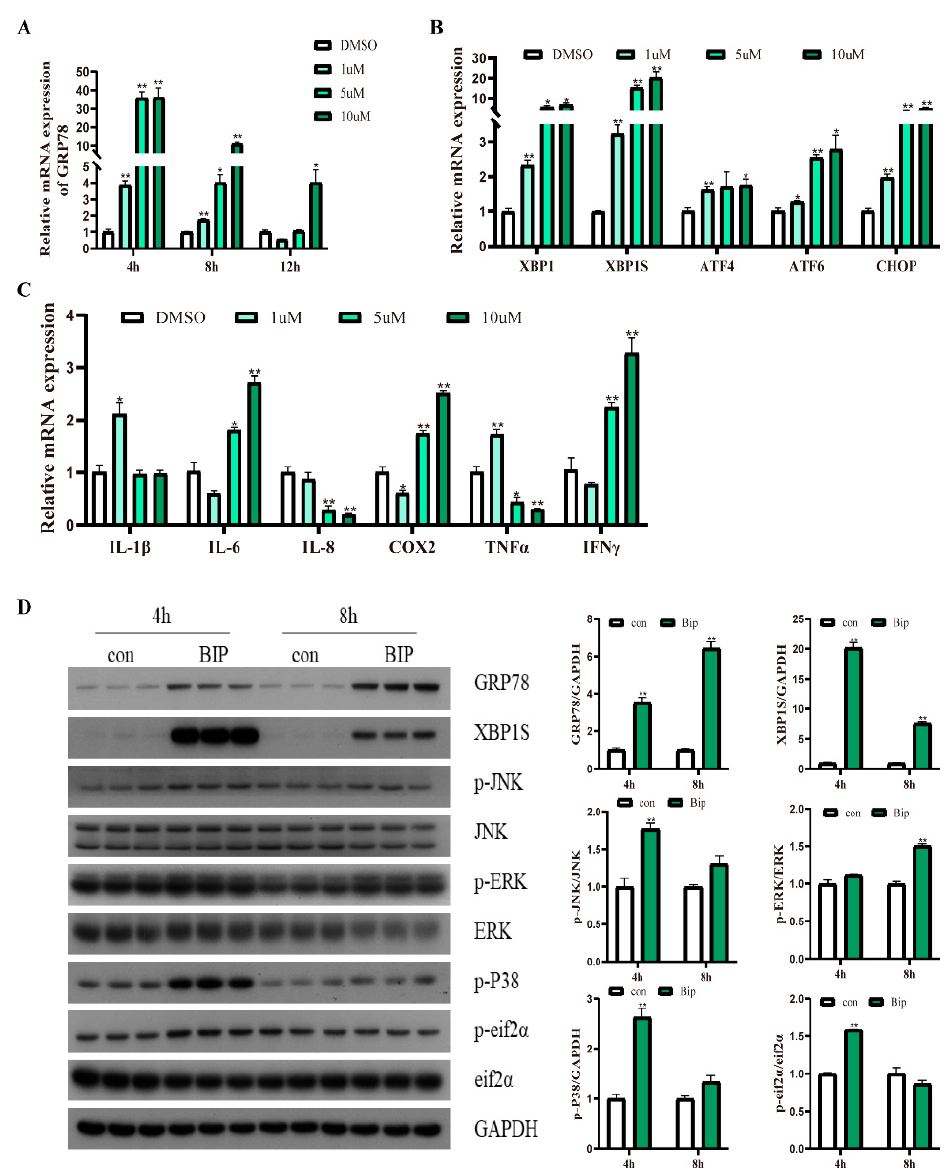
Figure 2. Effects of GRP78 agonist (BiP inducer X (BiP)) treatment on ER stress and inflammation in macrophages of large yellow croakers. ( A ) Relative mRNA expression of GRP78 after BiP treatment for different time points with different concentrations. ( B ) Relative mRNA expression of ER stress- related genes after BiP treatment for 4 h with different concentrations. ( C ) Relative mRNA expression of inflammatory genes after BiP treatment for 4 h with different concentrations. ( D ) Protein levels of ER stress-related proteins and inflammatory-related proteins after 10 µ M BiP treatment for 4 h and 8 h. Values are presented as mean ± SEM ( n = 3). * Significant difference ( p < 0.05); ** highly significant difference ( p <